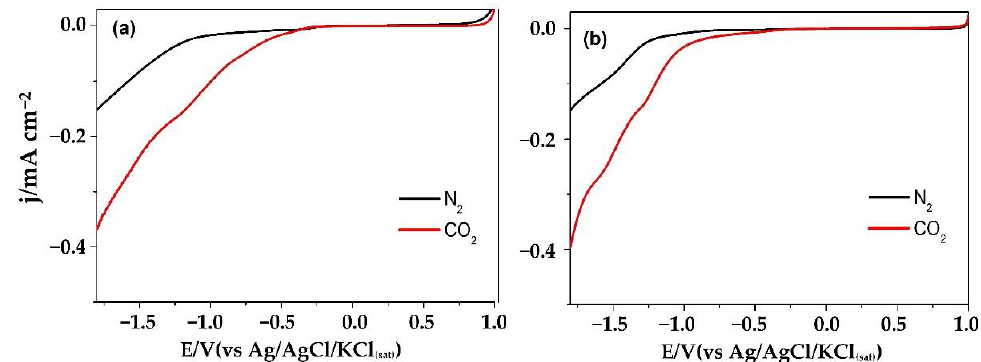
Figure 2. Linear sweep voltammograms taken in 0.1 M TBAF/ACN with TMO thin-film electrodes at 5 mV·s −1 scanning rate: ( a ) Fe 2 O 3 , ( b ) MoO 3 . The black and red curves correspond to scans under an atmosphere of N 2 and CO 2 , respectively.